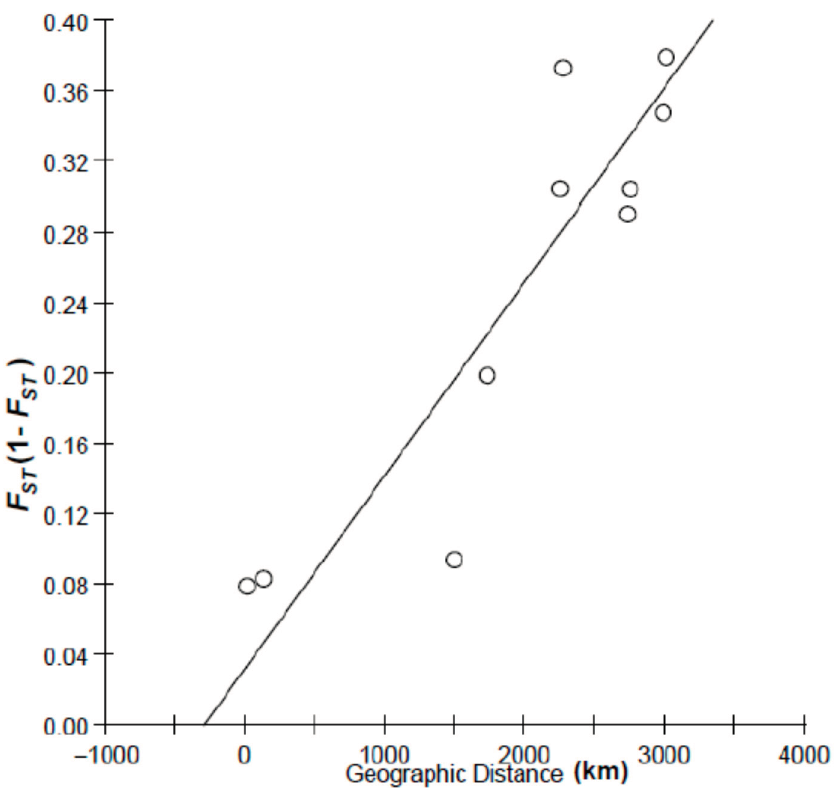
Figure 4. Plot of pairwise estimates of F ST /(1 − F ST ) vs. coastal distance between samples.